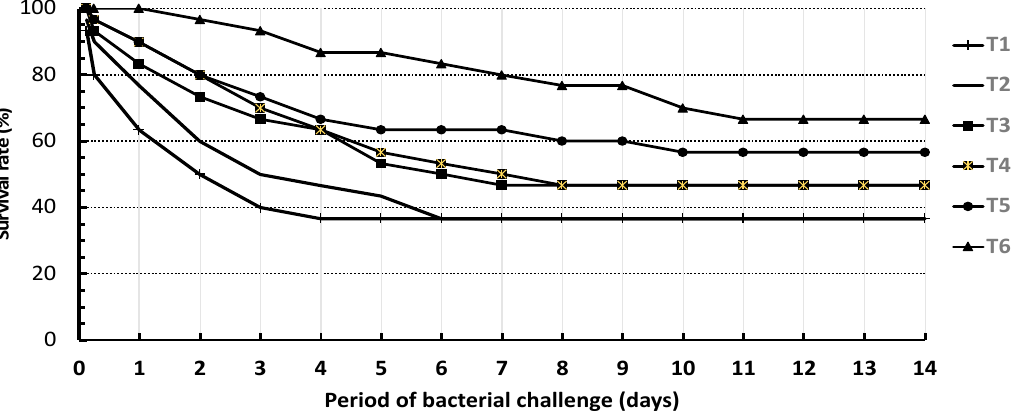
The bacterial challenge test showed very clear effects on the survival or the mortality rate right from the 6th hour after exposure to A. hydrophila (Figure 2).